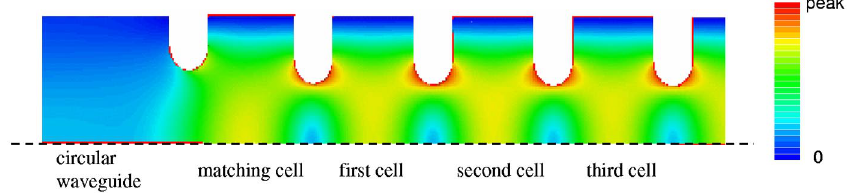
FIG. 8. (Color) Circular waveguide (left) matched to a traveling-wave periodic structure through a matching cell with electric field